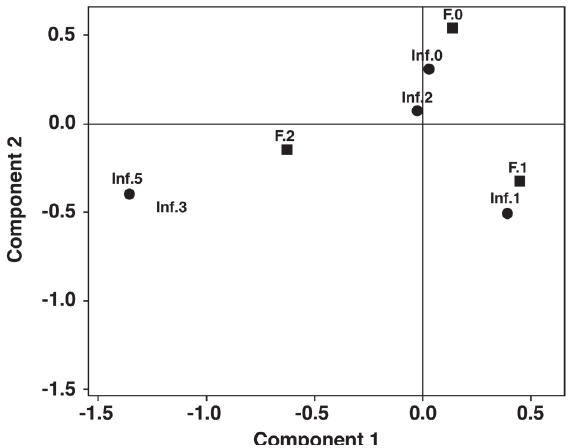
Figure 3- Correspondence analysis of microleakage vs.